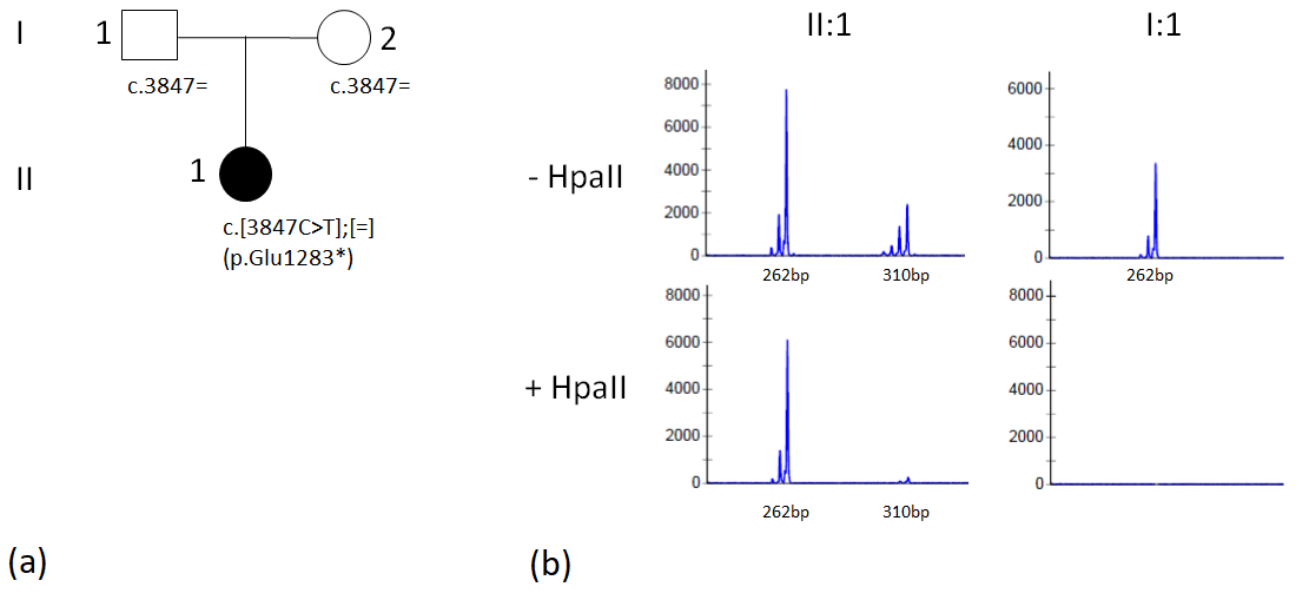
Figure 2. ( a ) Pedigree of the family; ( b ) analysis of X chromosome inactivation in our patient: fragment analysis results for the AR locus. Fragment analysis of undigested ( − HpaII) and digested (+ HpaII) DNA from the proband (II:1) and her father (I:1). After HpaII digestion, DNA from the male individual (I:1) cannot be amplified with PCR, while DNA from the proband shows a skewed (about 87%) X chromosome inactivation.